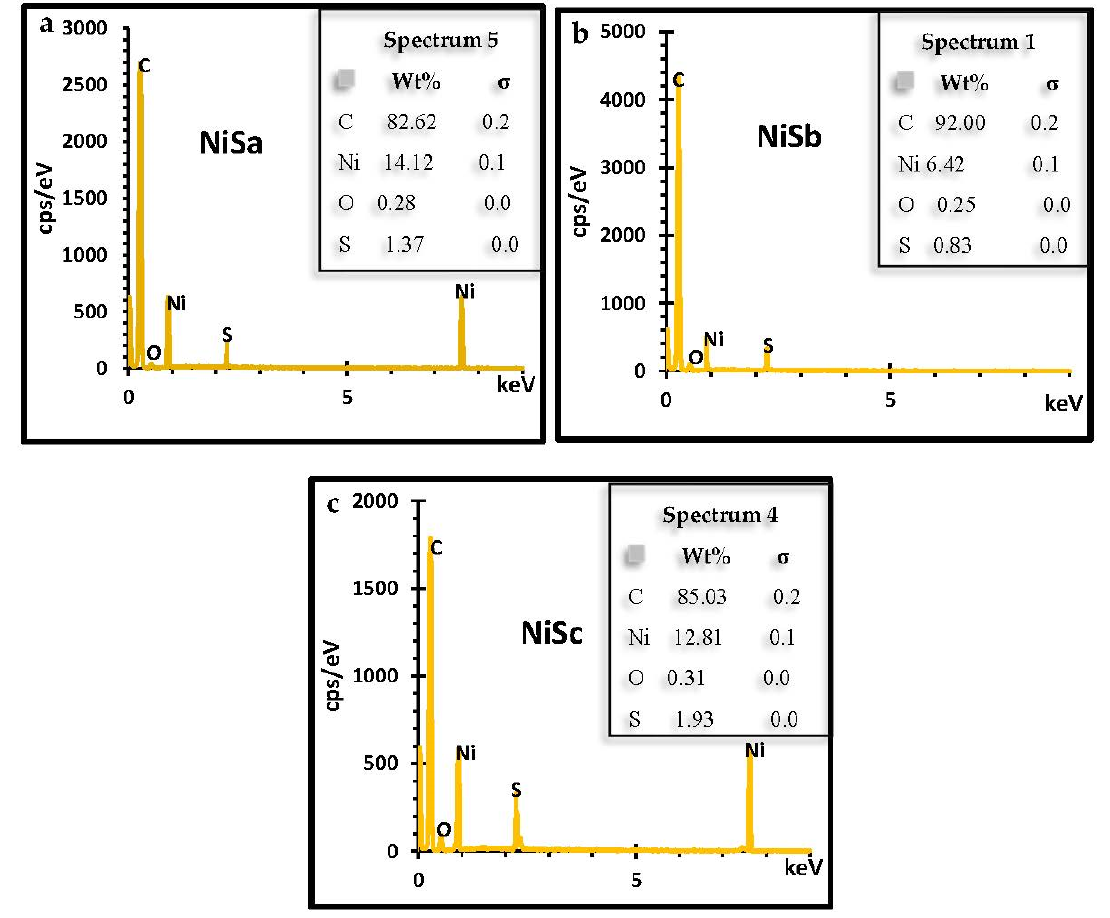
Figure 7. EDS spectra of NiSa ( a ), NiSb ( b ), and NiSc ( c ) nanoparticles.